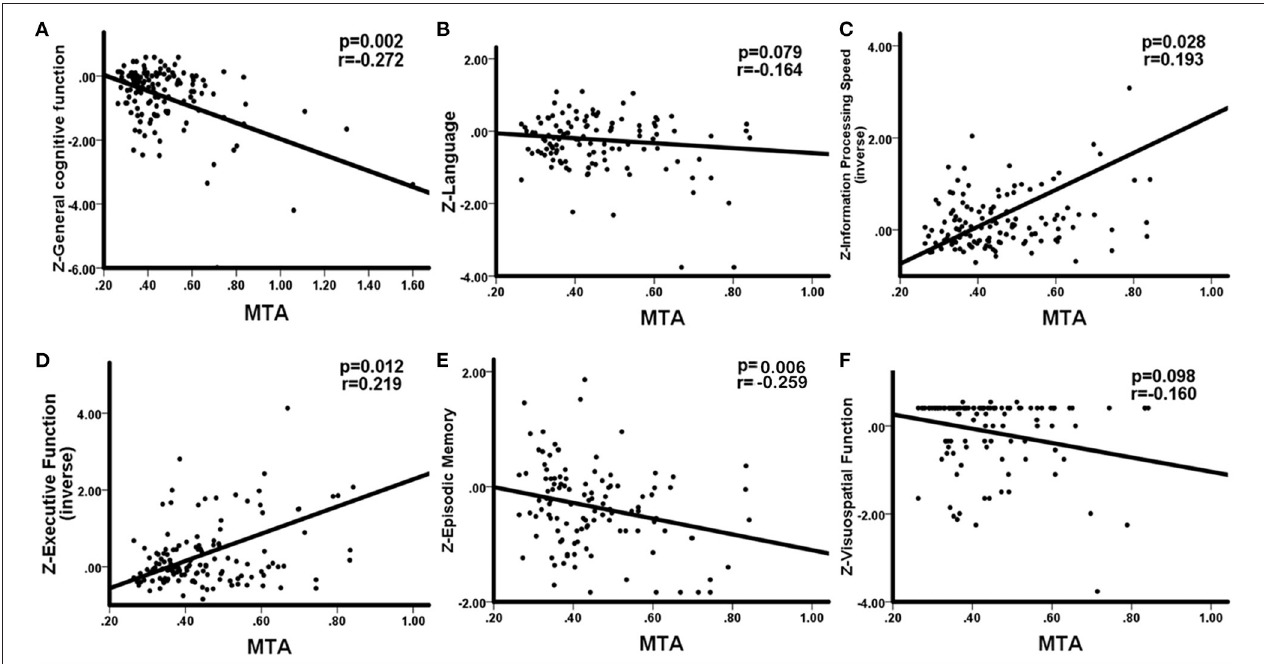
FIGURE 3 | Correlations between MTA and cognitive function in CSVD-CI patients. Partial correlation was conducted by controlling for age, gender, years of education, history of hypertension, and history of LI/TIA in CSVD-CI group. (A) MTA correlated negatively with general cognitive function. (B) No significant correlation was observed between MTA and the language domain. (C) MTA had a negative correlation with information processing speed. (D) MTA had a negative correlation with executive function. (E) MTA correlated negatively with episodic memory. (F) No significant correlation was observed between MTA and visuospatial function. MTA, medial temporal atrophy, the ratio of the ipsilateral lateral subventricular horn to hippocampal volume; CSVD-CI, cerebral small vessel disease patients with cognitive impairment; TIA, transient ischemic attack; LI, lacunar